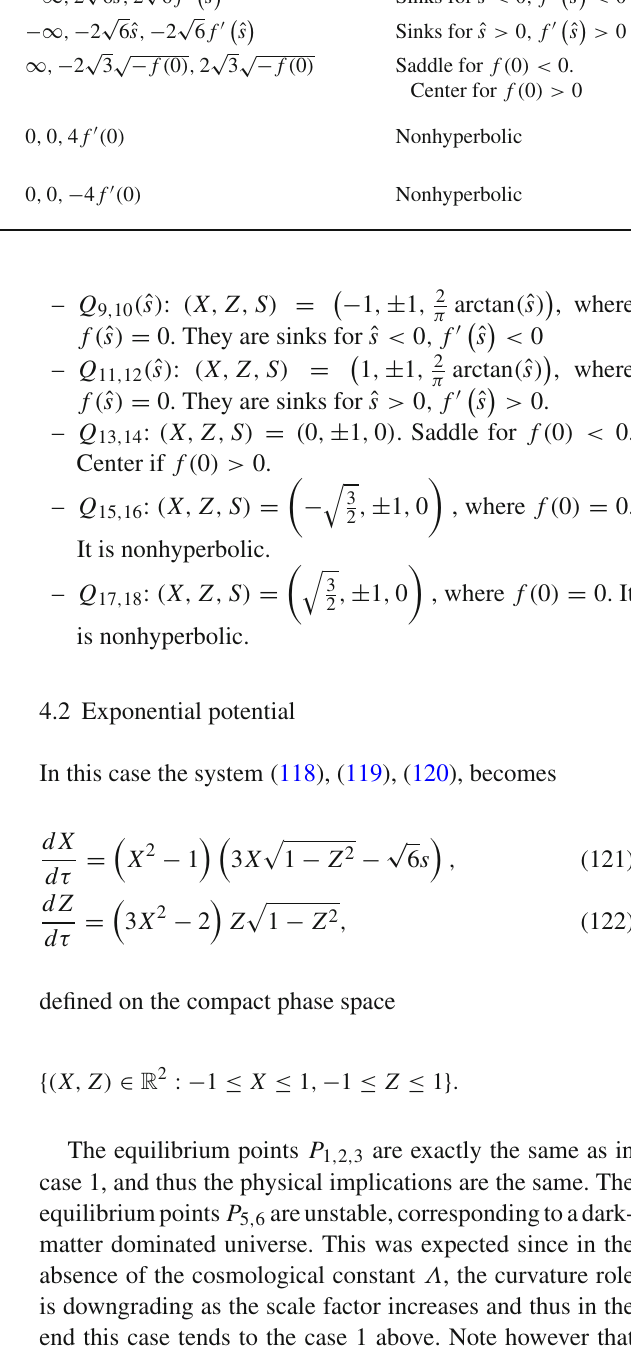
Table 4 Case 2: Equilibrium points at the infinity region of the system (113), (114), (115) Equil. points ( x , Z , S ) Existence Eigenvalues Stability Q 9 , 10 ( ˆ s )